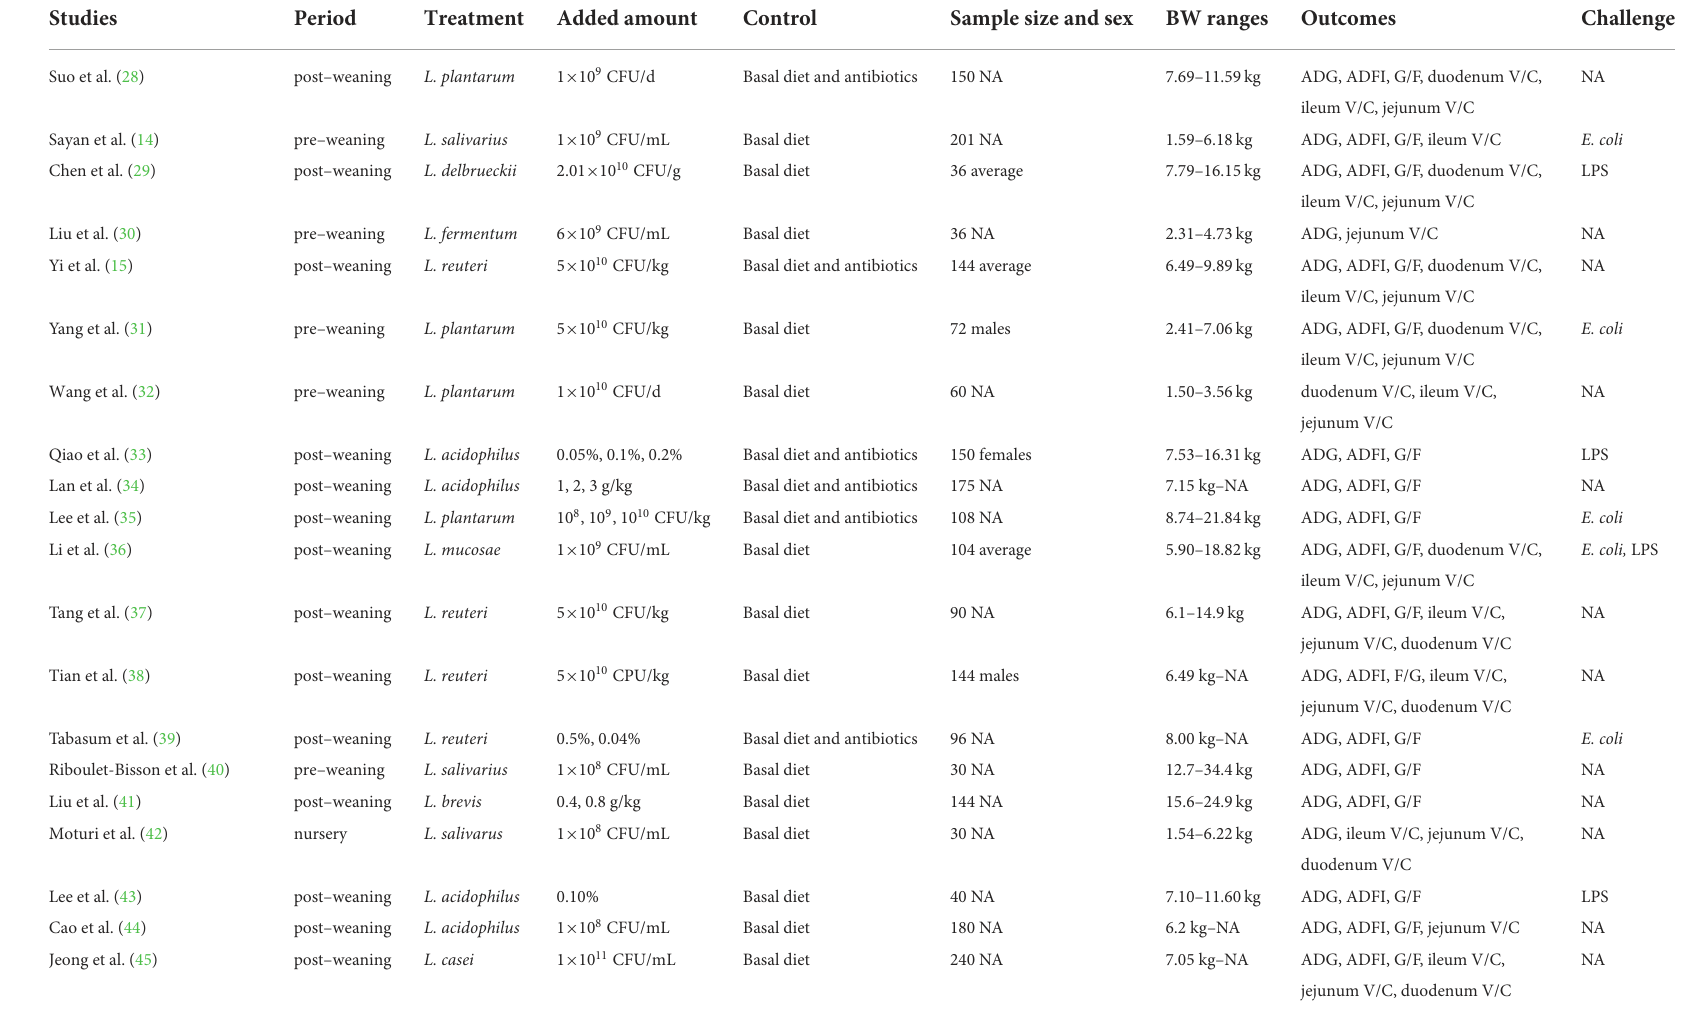
TABLE 1 Information of included studies on the effects of Lactobacillus -based probiotics in pigs a